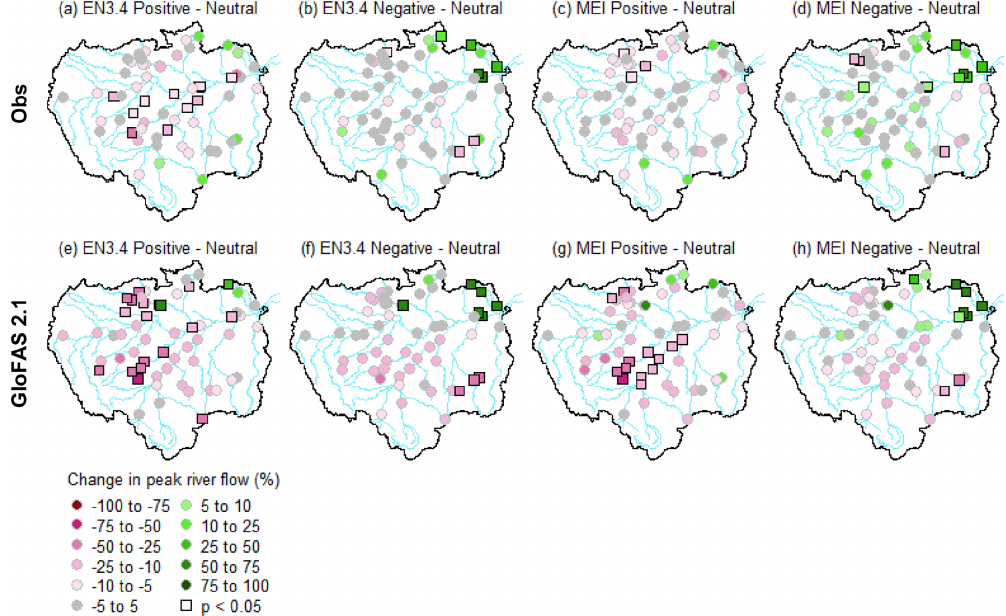
Figure 2. Percentage change of observed and simulated mean annual peak river flows between different phases of the EN3.4 and MEI indices. (a, c, e, g) Positive with respect to neutral years. (b, d, f, h) Negative with respect to neutral years. Panels (a–d) represent changes for observations and panels (e–h) show changes for GloFAS 2.1 streamflow reanalysis data. Pink (green) points represent where the average annual peak flow decreases (increases). Significant results at the 95% confidence level are denoted using a square (i.e. p < 0 .